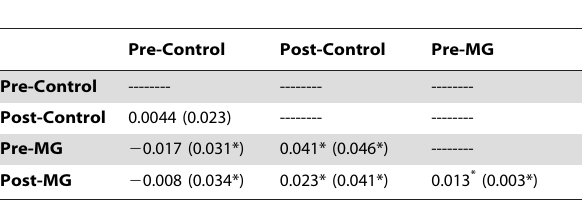
Table 4. Genetic structure (pairwise F st values) for the MHC and microsatellite loci examined (microsatellite results shown in